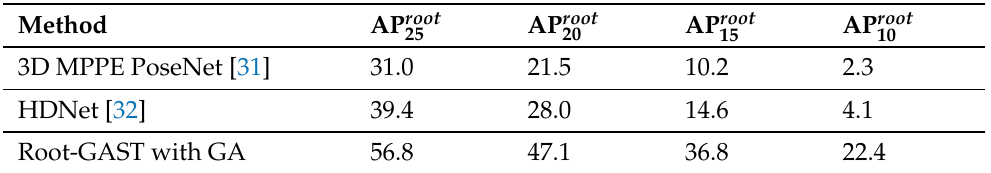
Table 3. Average precision of the root keypoint evaluation by different distances on the MuPoTS- 3D dataset.